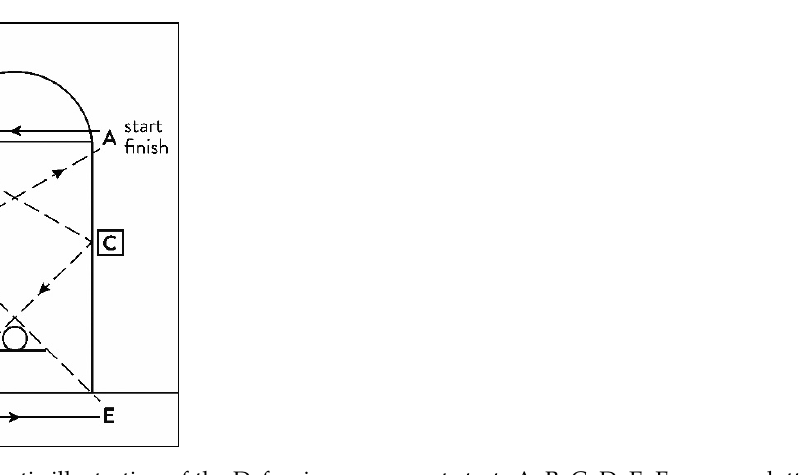
Figure 2. Schematic illustration of the Defensive movements test. A, B, C, D, E, F—cones; dotted arrow—direction of movements.